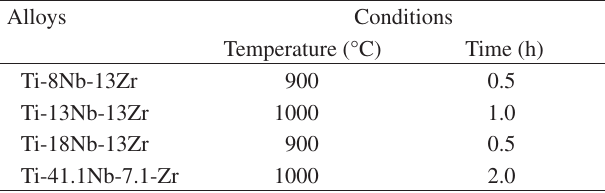
Table 1. Conditions of heat treatment after cold - working.